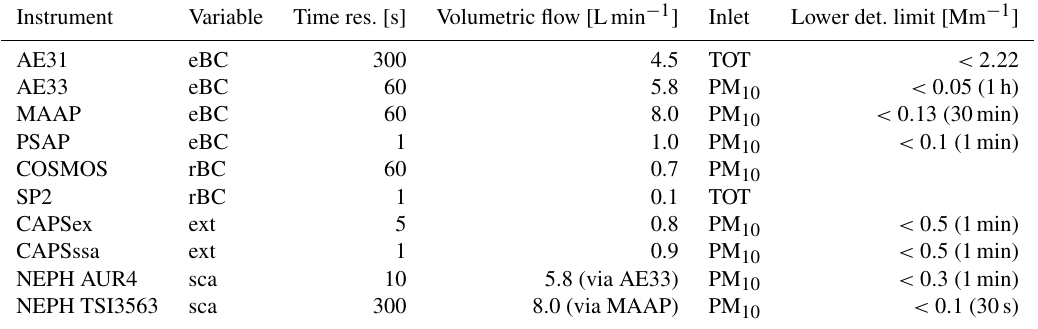
Table 1. The campaign instrumentation presented in columns: (1) instrument abbreviation, (2) variable measured (scattering : sca; extinction : ext; refractory black carbon : rBC; equivalent black carbon : eBC; particle number concentration : PN), (3) measurement time resolution, (4) flow rate, (5) instrument inlet (cut size 10µm : PM 10 ; total inlet : TOT), and (6) lower detection limit based on manufacturer information.